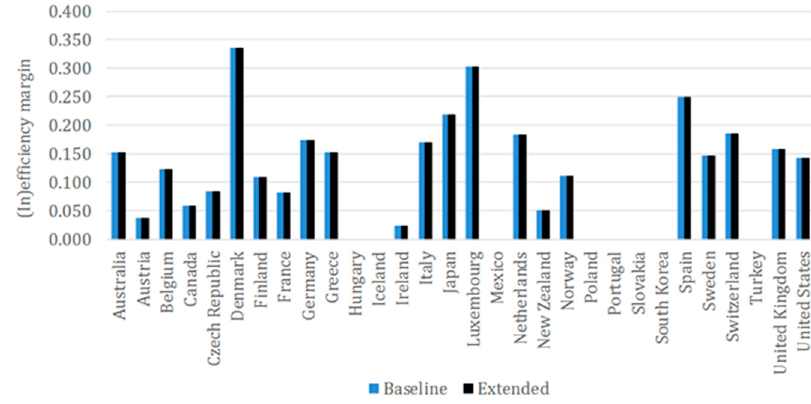
Figure A6. (In)efficiency scores for primary energy.